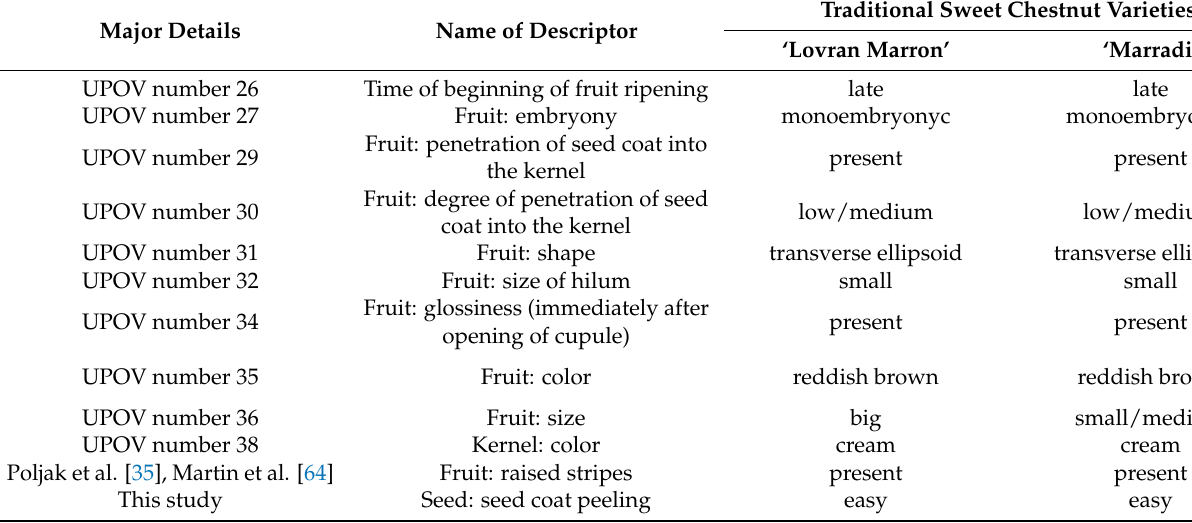
Table 2. Standardized